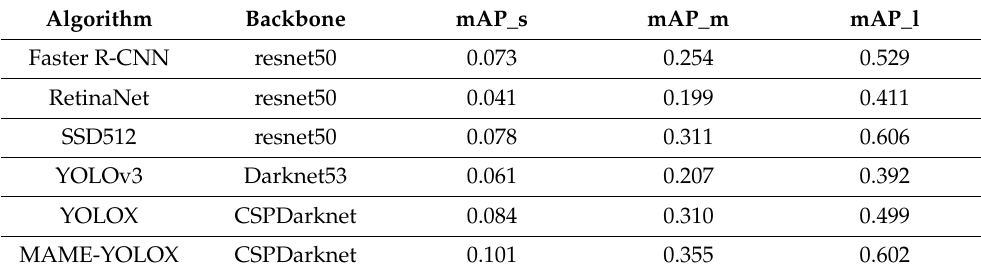
Table 7. Comparative experimental results of different algorithms on the DIOR dataset.